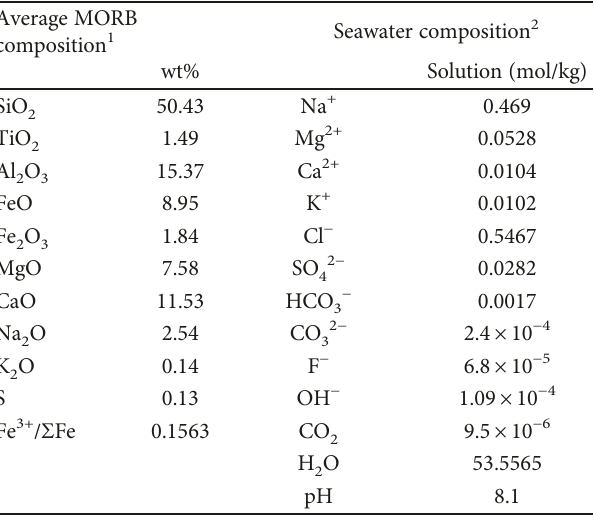
Table 1: Average MORB and seawater compositions integrated in the calculations of this